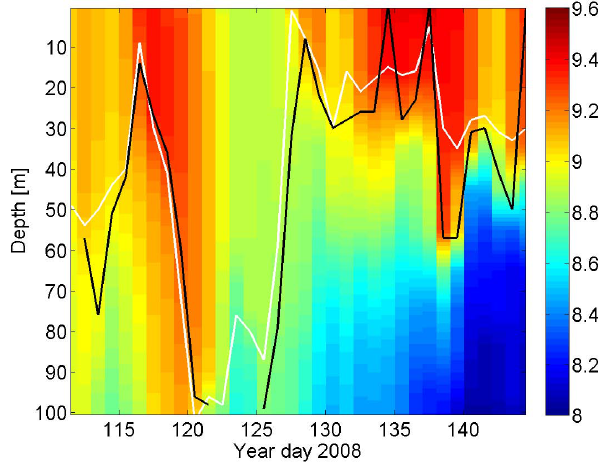
Fig. 3. Simulated temperature [ ◦ C], model-derived MLD (white line) and observed MLD (black